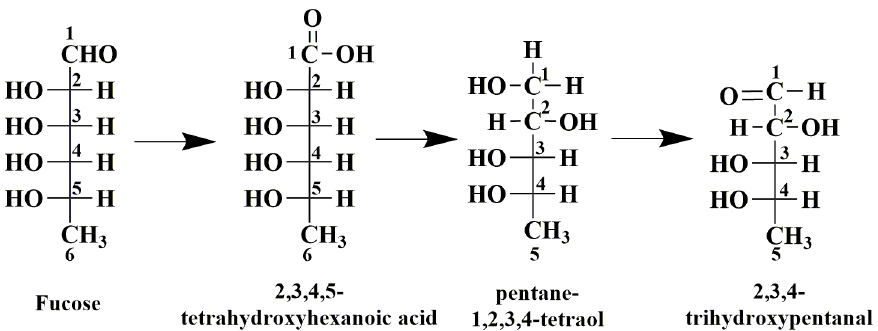
Figure 3. Extracted-ion chromatograms and MS 2 of PMP-labeled oligosaccharides in the DF-3.